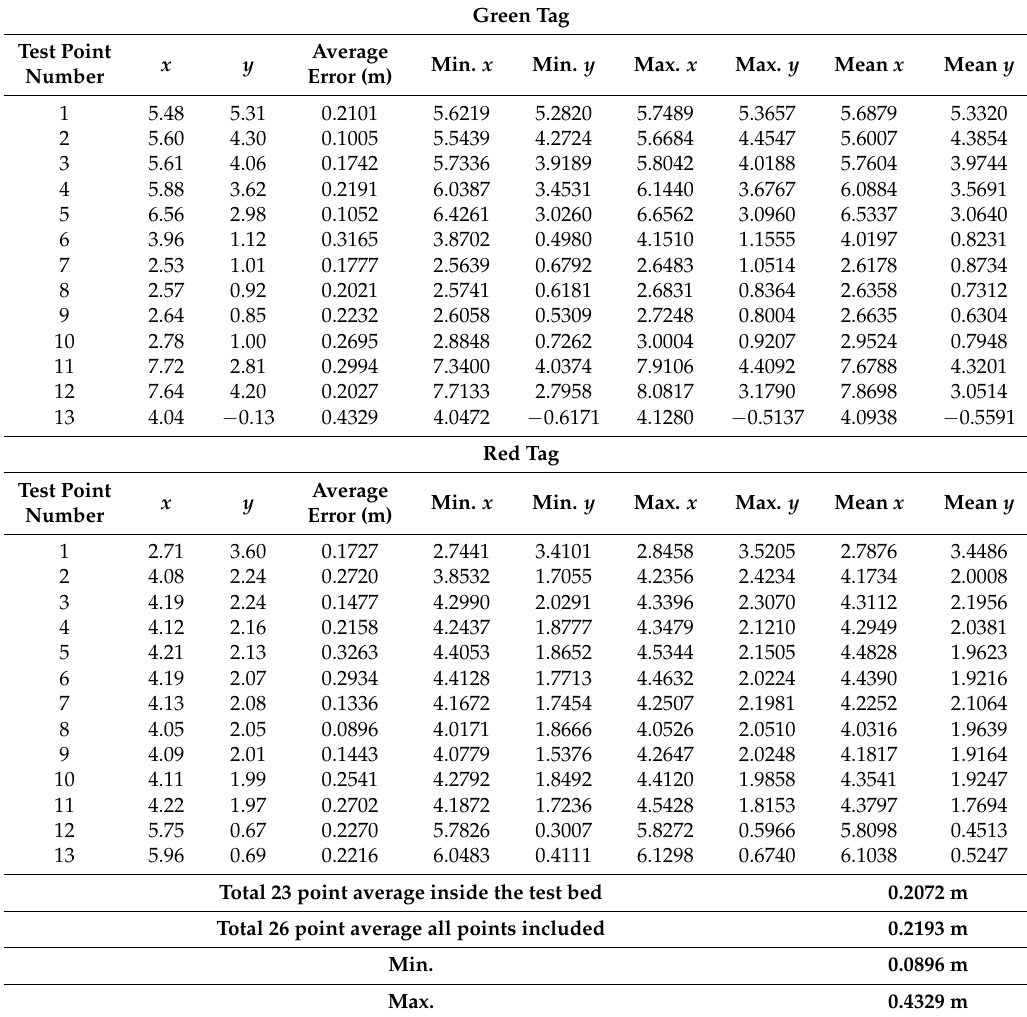
Table 4. The mean average error of 180 measurements per test point, with a total of 4680 (26 test points × 180 samples) measurements from 26 test points for ultra-wide band sensors. The mean average was reported as 0.2072 m, including 23 test points inside the test bed, and 0.2193 m, including all 26 test